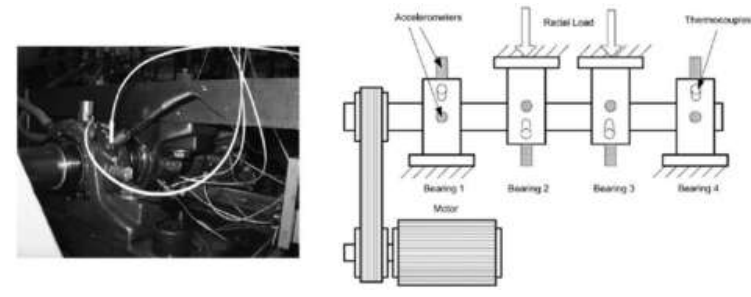
Figure 5. Rolling bearing experimental setup at IMS. Table 1. Measures under different fault conditions.